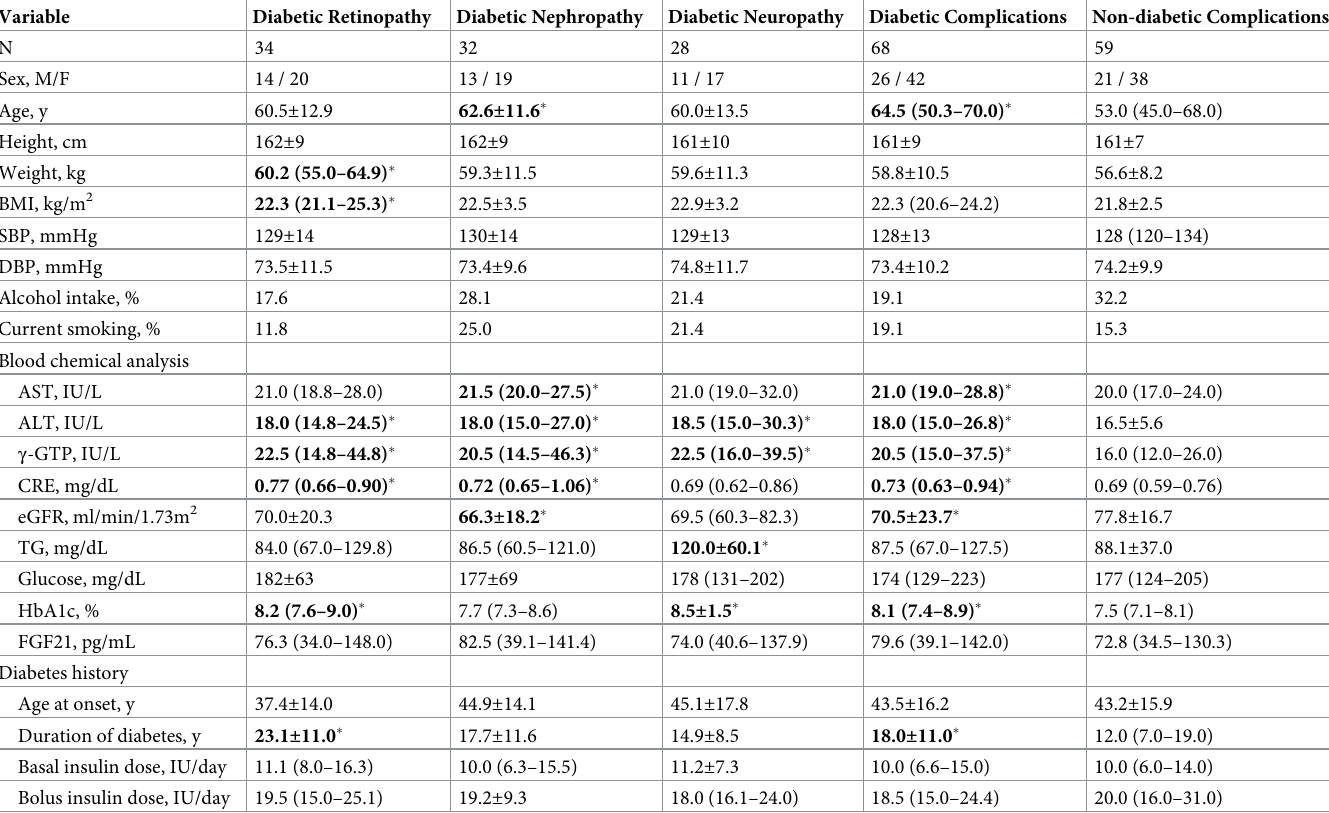
Table 2. Characteristics of type 1 diabetic patients with and without diabetic complications.